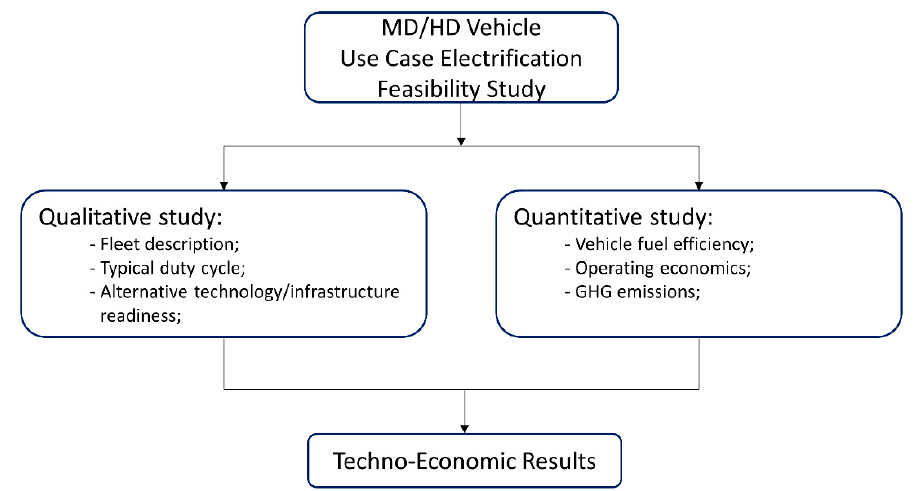
Figure 1. Flow chart of the research approach. Table 1. MD/HD vehicles evaluated and estimated fleet sizes in Canada.